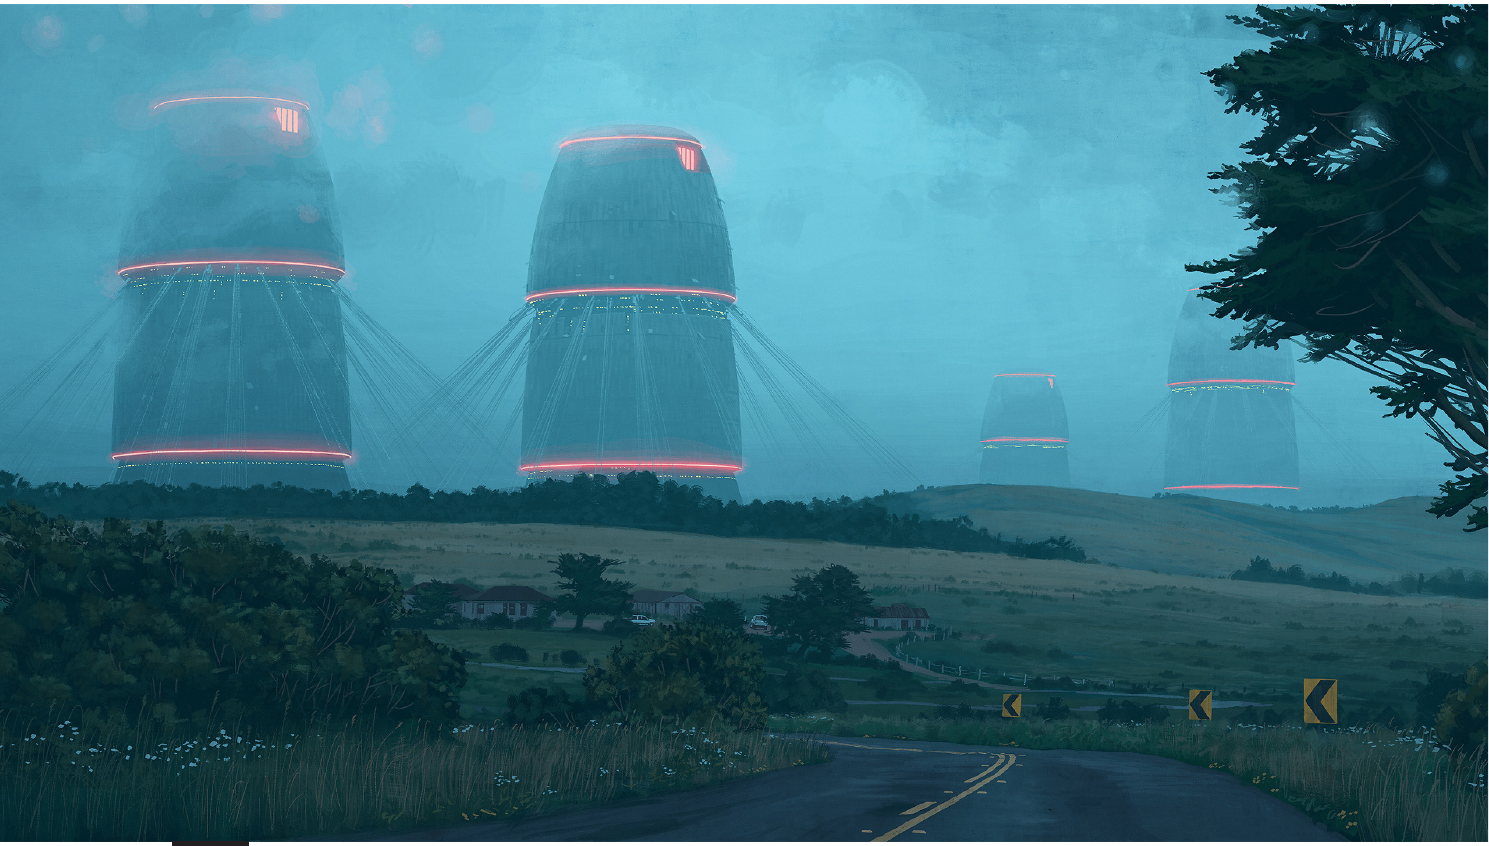
Simon Stålenhag, The Electric State , pp. 78-79, 2017 © 2017 Simon Stålenhag FIG.